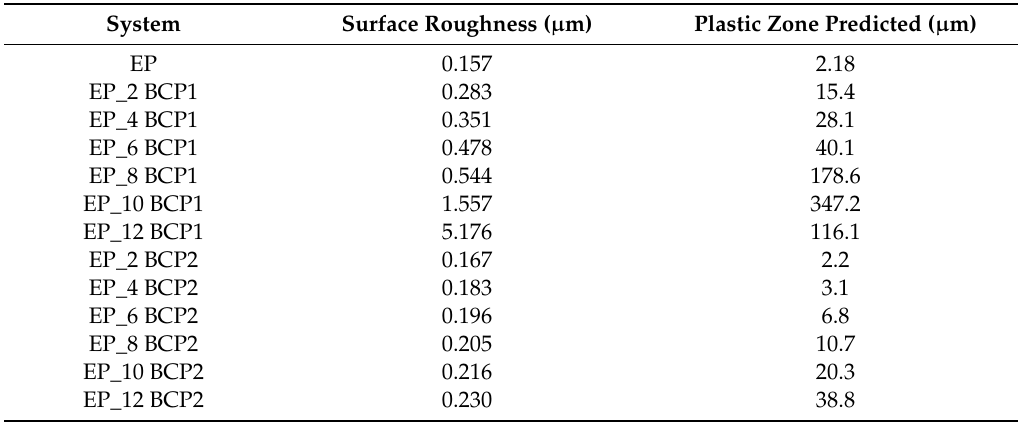
Figure 5. ( a ) 2D and ( b ) 3D profilometry micrograph showing the topography of the fractured surfaces for EP_6BCP1 and ( c , d ) for EP_6BCP2 systems, respectively. AFM (height) images of ( e ) 6BCP1 and ( f ) 6BCP2 modified systems. Table 4. Surface roughness values of CT fractured samples for di ff erent EP _BCP systems measured from while light profilometry and predicted plastic zone size of